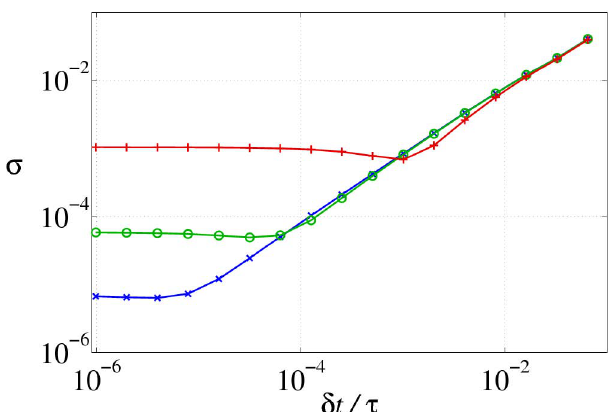
Fig. B1. Variation of σ at t = 0 . 1 τ as a function of the time step. Three different space discretization intervals are considered: δr = 10 − 2 (– × ); δr = 2 × 10 − 2 (– ◦ ); and δr = 5 × 10 − 2 (– |